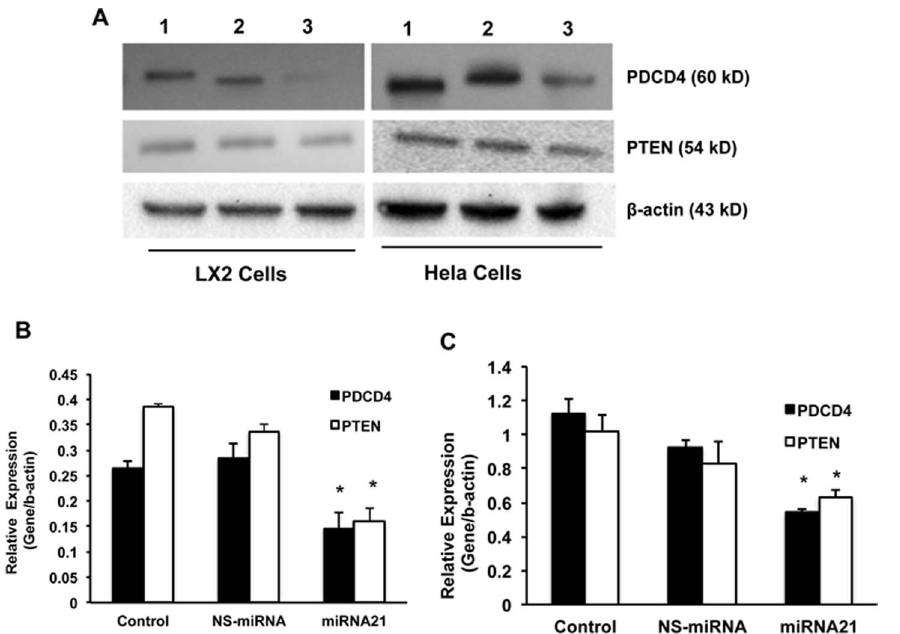
Figure 9. Effect of miRNA-21 on PDCD4 and PTEN proteins in LX2 and Hela Cells. A, shows a representative picture of Western blot results of miRNA-21 target proteins, PDCD4 and PTEN in miRNA-21 over-expressing LX2 and Hela cells. As an internal control b -actin was used in all the Western blot experiments. Lane 1, Control; lane 2, NS-miRNA transfected cells; and lane 3, miRNA-21 transfected cells. The Western blots were quantified and the data are presented for LX2 (B) and Hela (C) cells (n=3; *p , 0.05).